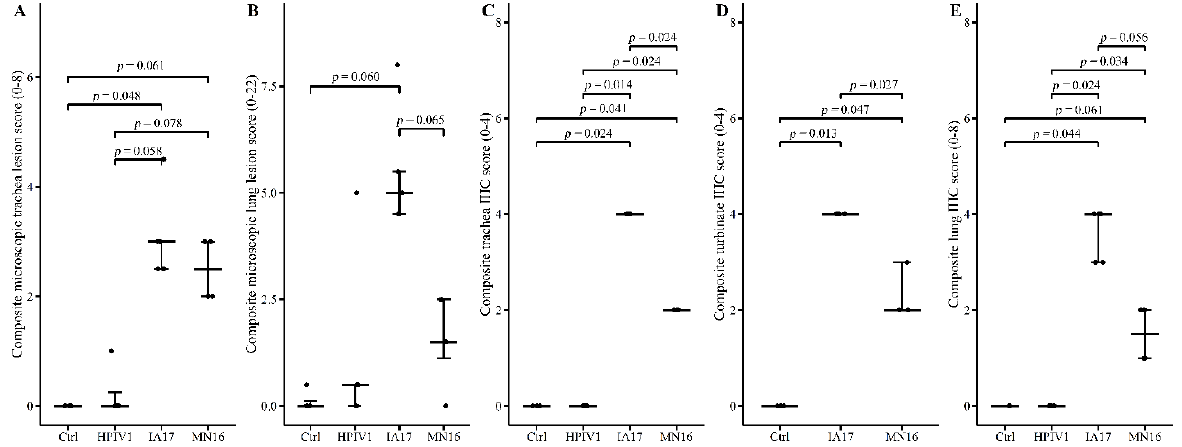
Figure 5. Microscopic lesion and IHC scores by treatment group at 5 DPI. Error bars represent 25th, 50th, and 75th quartiles, respectively. Points are jittered horizontally to prevent overplotting. Significance brackets are provided if p < 0.1. ( A ) Microscopic composite trachea lesion score. Pig 8168 from the MN16 group was missing and not included in the analysis. ( B ) Microscopic lung lesion scores. ( C ) Microscopic trachea IHC scores. ( D ) Microscopic nasal turbinate IHC scores. The HPIV group was excluded from this analysis due to missing observations. Pig 8157 from the MN16 group was missing and not included in the analysis. ( E ) Microscopic lung IHC scores.